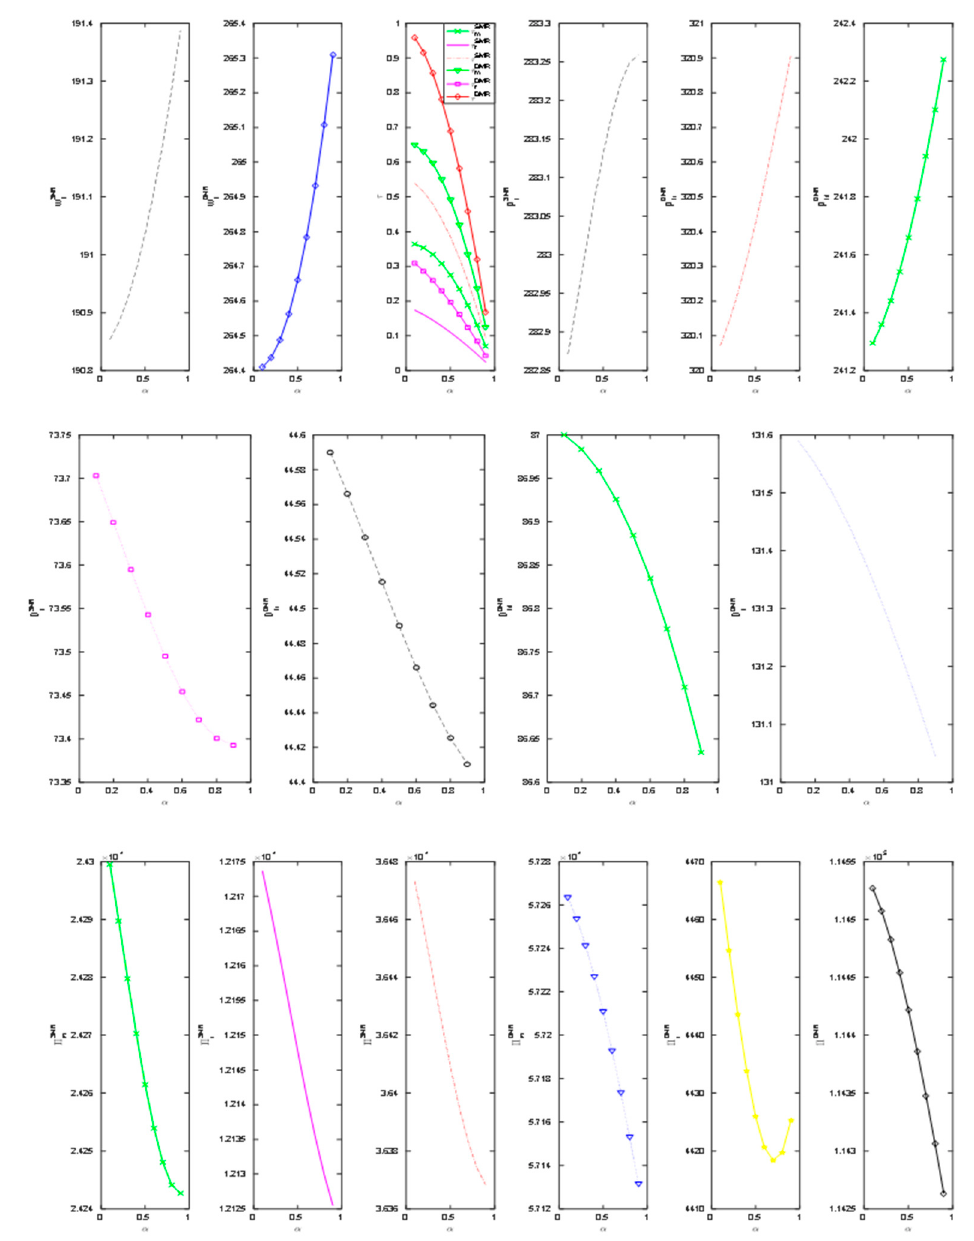
Figure 10. Changes of the wholesale price/collecting rate/selling price/market demand/profit with α